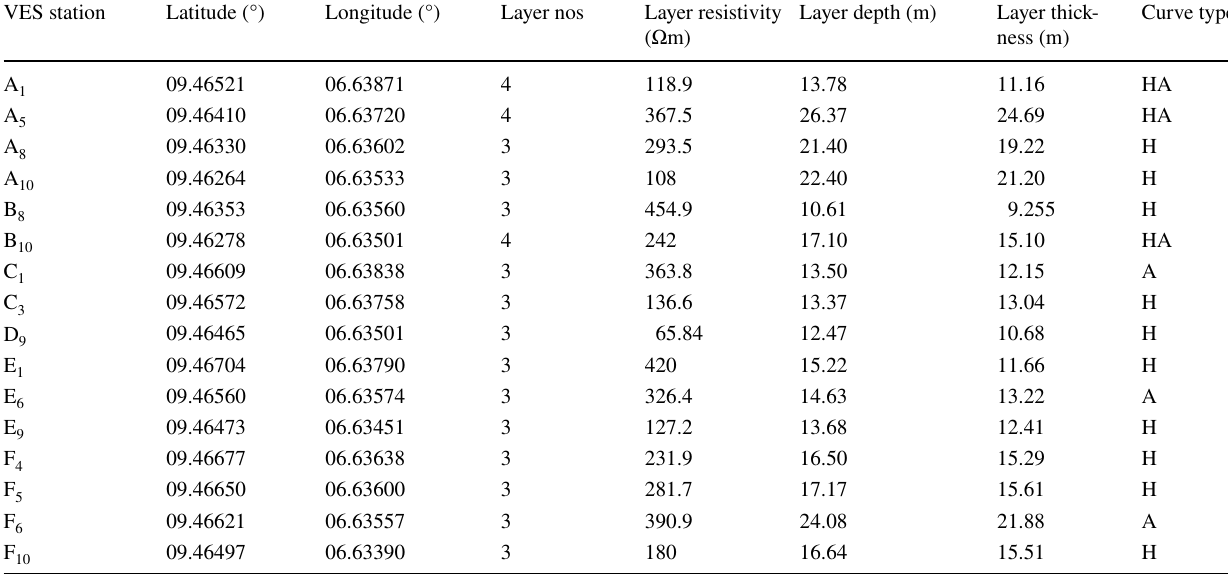
Table 4 Recommended aquifer potentials of the study